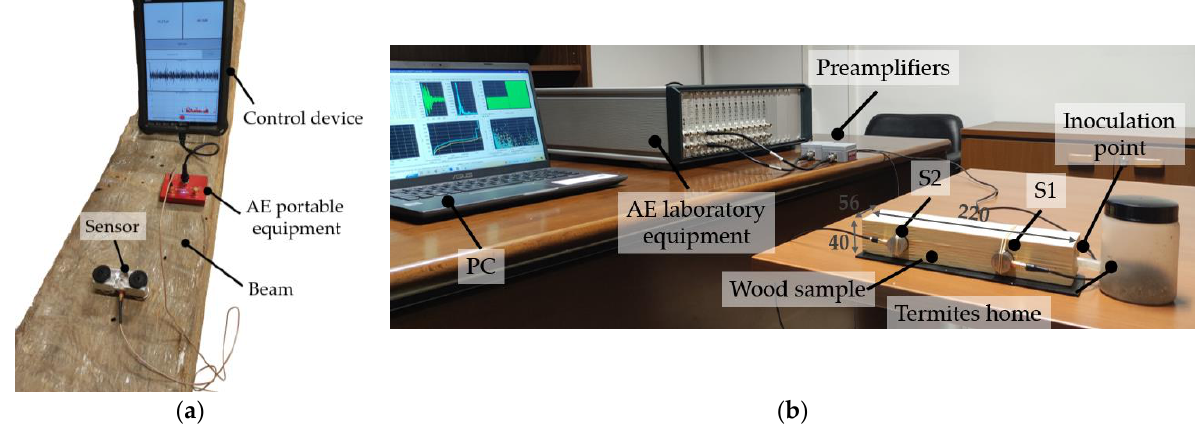
Figure 6. Acoustic emission setup ( a ) in situ on the wooden beams of the floor and natural environ- ment conditions (portable acquisition system); ( b ) in laboratory on wooden samples under controlled conditions (laboratory acquisition system). Distances in mm.